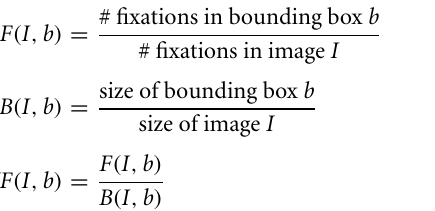
FIGURE 4 | Normalized proportion of fixations by category for the Pascal (top)andSUN09(bottom)datasets. Abaselineindicatingchancefixationwas computed for individual participants by finding for each trial another trial with